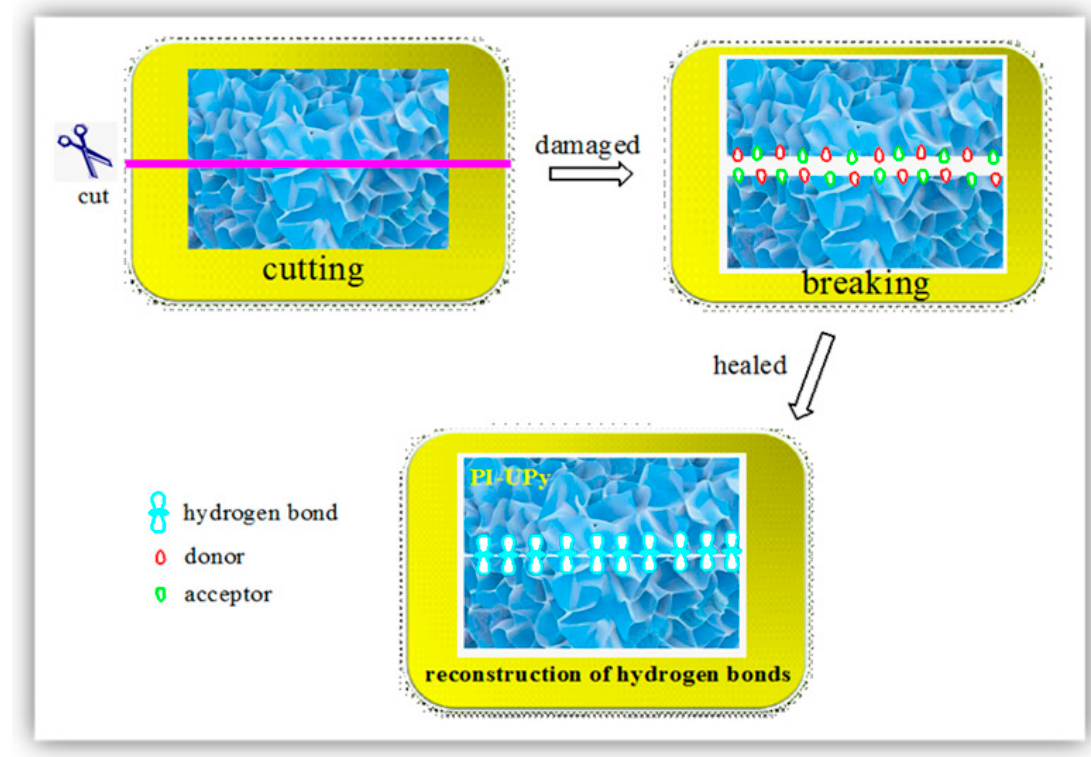
Figure 11. Schematic illustration of damage and self-healing process of